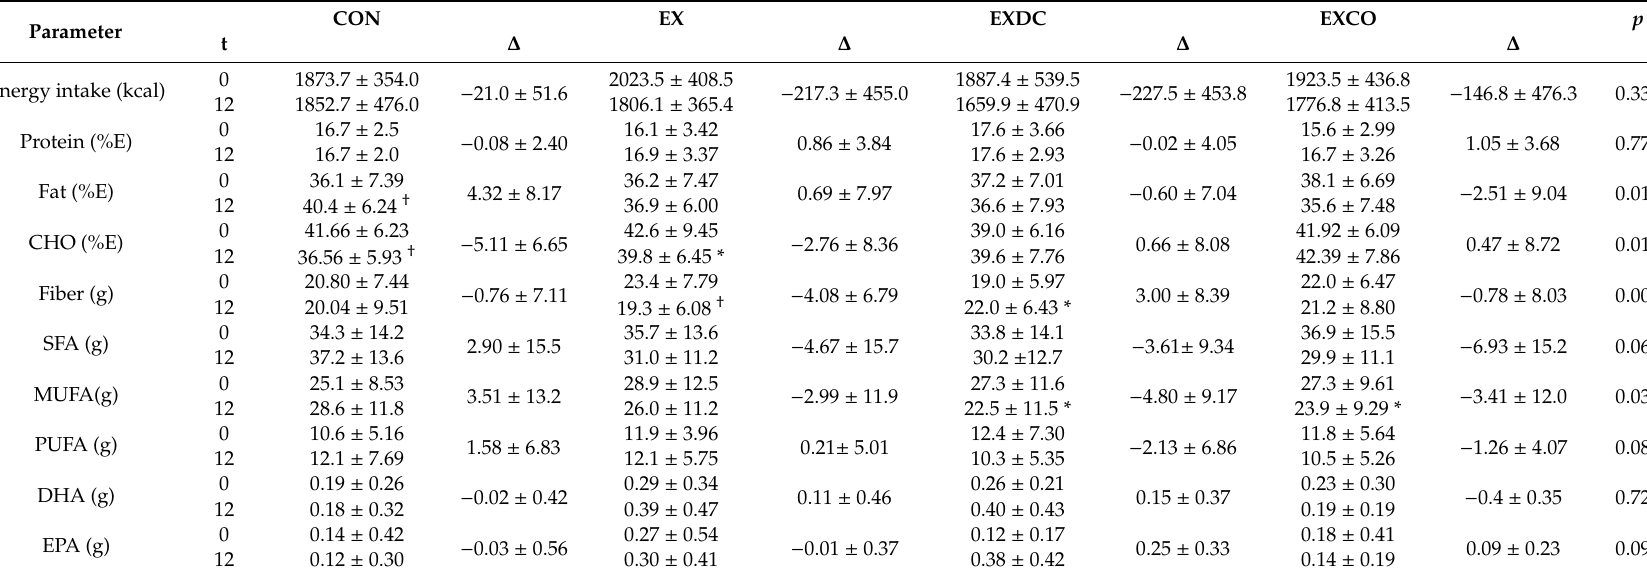
Table 3. Daily dietary intake from the background diet calculated from 3-day dietary records and absolute changes ( ∆ ) at the beginning (0) and at the end (12) of the